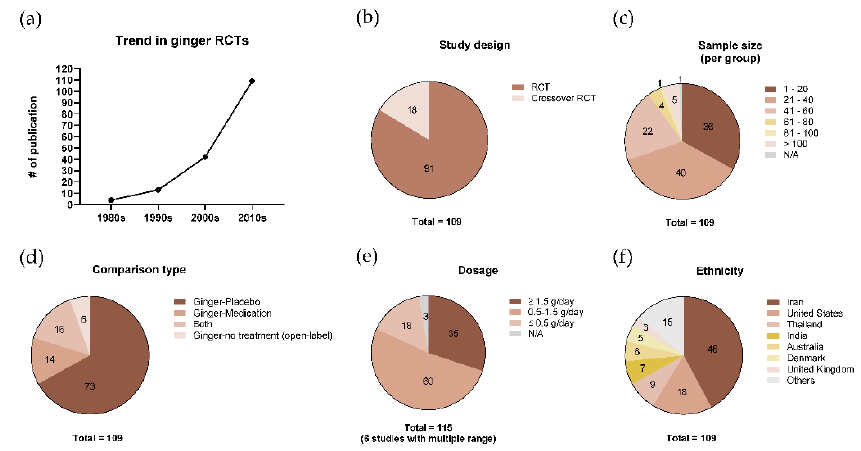
Figure 2. Features of ginger Randomized controlled trial (RCT) characteristics. ( a ) The trend in the publication of ginger RCTs over the decades, ( b ) the types of study design, ( c ) the ranges of pooled sample size per group, ( d ) the types of comparison in intervention, ( e ) the ranges of adopted dosage, and ( f ) the variety of ethnicity. N/A: Not available.